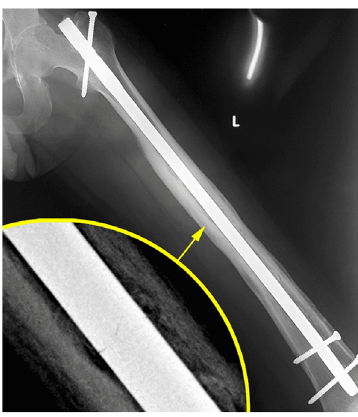
Figure 1. Antero-posterior view of full-length X-ray of the left femur showing broken femur nail with complete bony union.